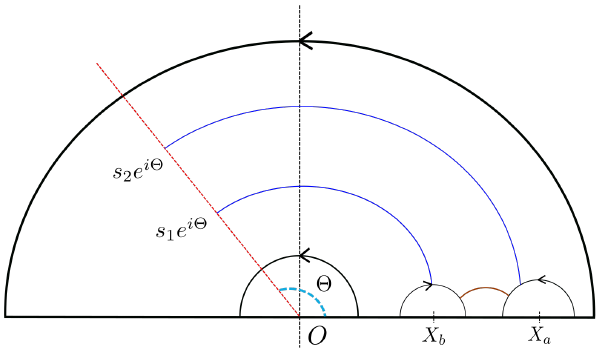
Figure 5. The covering space of the multiboundary wormhole from the inception geometry side. Considering that a candidate RT surface for radiation subregions R 1 and R 2 can pass through the EoW brane from the inception geometry to the real geometry, the blue lines are drawn, which correspond to the minimal ones anchoring on the EoW brane. It will close in the actual black hole side not shown in this